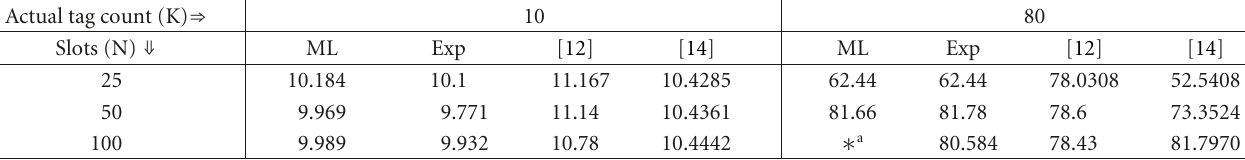
Table 2: Comparison of estimation